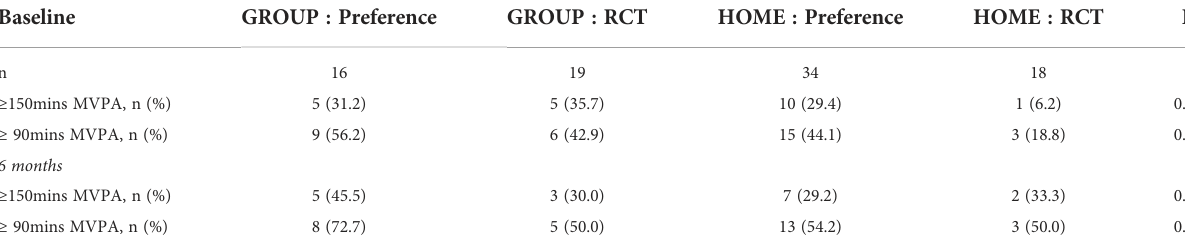
TABLE 5 Adherence between preference and RCT participants.